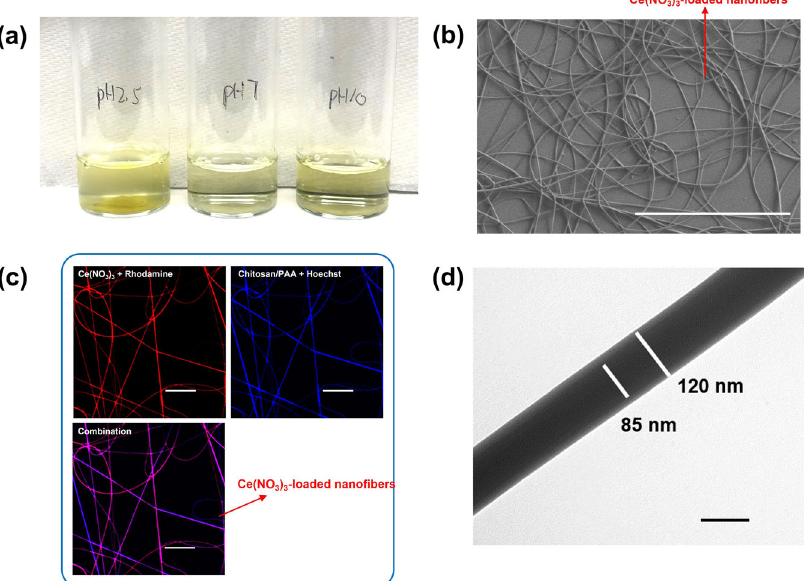
Fig. 1 Dual-pH-responsive behavior of the chitosan/PAA coacervate and characterization of Ce(NO 3 ) 3 -loaded nano fi bers. a The release of BB in DI water with varied pH for 24 h. b The surface morphology of Ce(NO 3 ) 3 -loaded nano fi bers examined by SEM. Scale bar is 20 µm. c Ce (NO 3 ) 3 -loaded nano fi bers observed by confocal spectroscopy. Scale bar is 20 µm. d The core-shell structure of an individual Ce(NO 3 ) 3 -loaded nano fi ber con fi rmed by TEM. Scale bar is 100